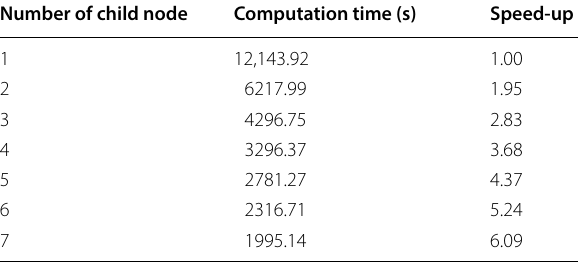
Table 1 Parallel computation performance by